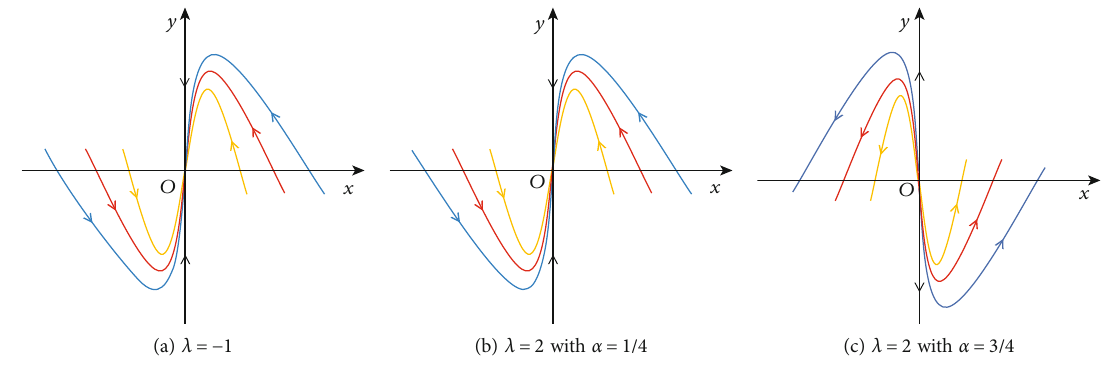
Figure 6: The phase portraits of system (13) at di ff erent α